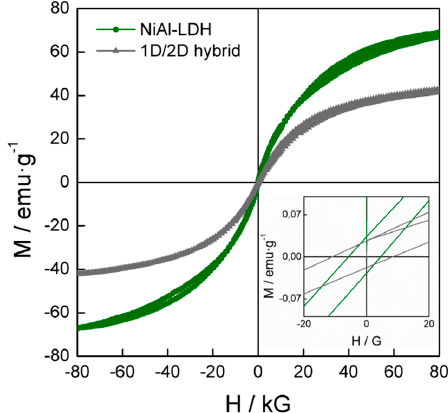
Figure 7. Hysteresis cycle at 2 K of the pristine NiAl–LDH and the 1D/2D hybrid . The inset represents the low field region. The plot shows the dramatic magnetization decrease after the hybridization of the ferromagnetic NiAl–LDH with the diamagnetic 1D-CP(Cd) −